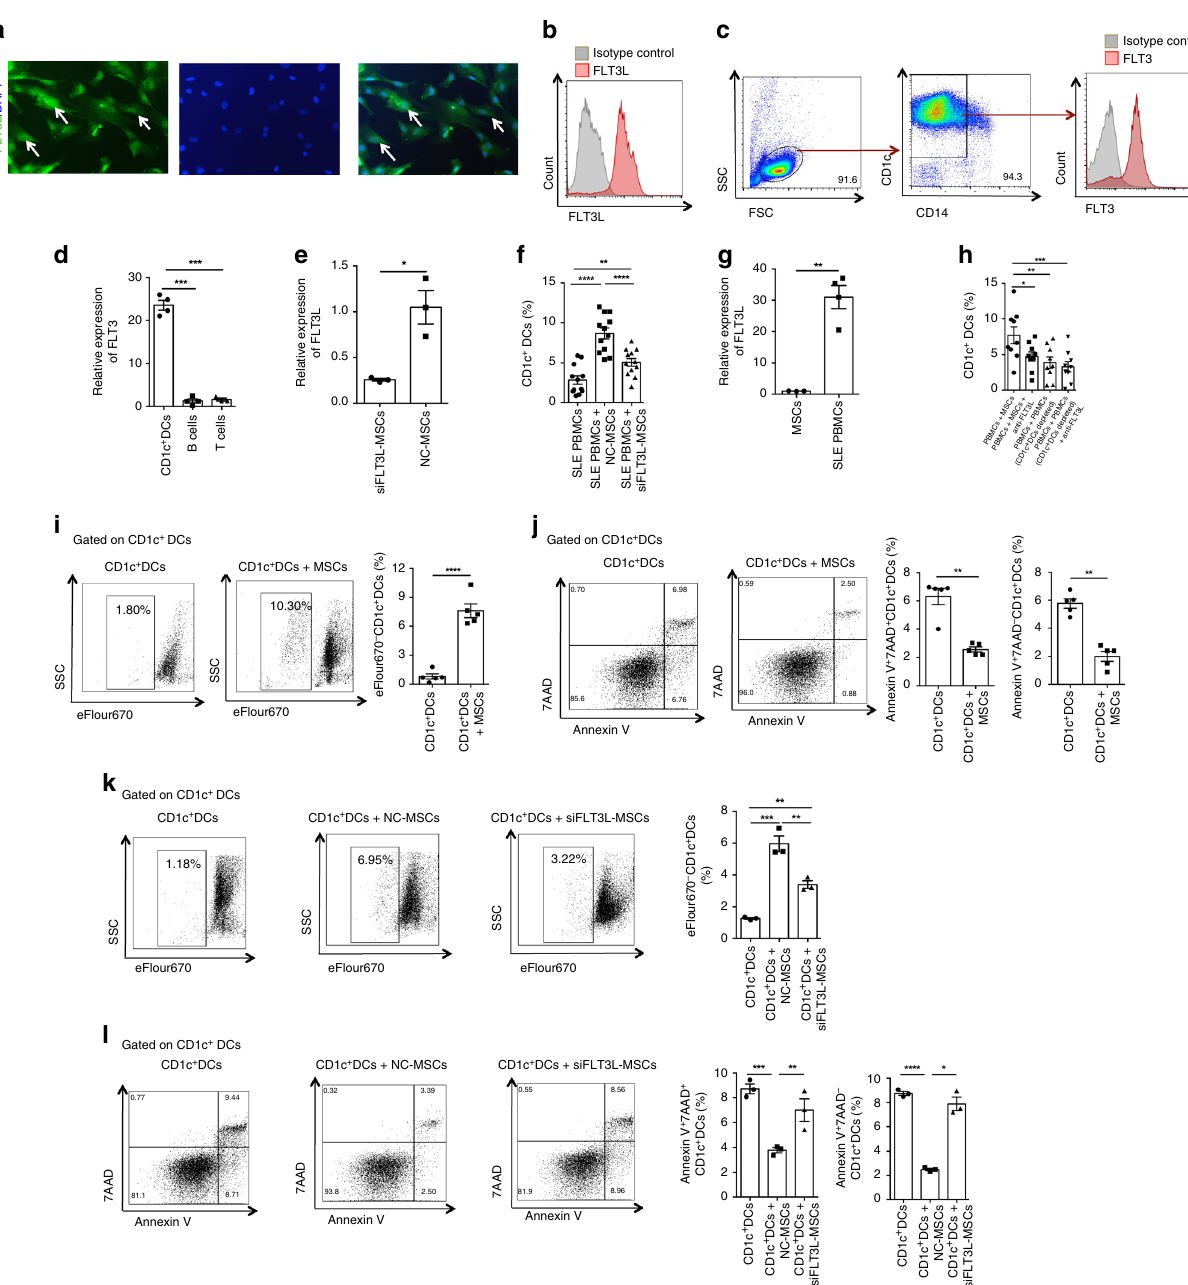
Fig. 4 UC-MSCs up-regulate CD1c + DCs via FLT3L. a The expression of FLT3L on UC-MSCs was assessed by immuno fl uorescence staining (Green: FLT3L; Blue: DAPI), white arrows represented FLT3L expression. b The expression of FLT3L on UC-MSCs was assessed by fl ow cytometry. c CD1c + DCs are isolated and identi fi ed by fl ow cytometry. Flow cytometry analysis showed the expression of FLT3 on CD1c + DCs. d The relative expression of FLT3 was compared among isolated CD1c + DCs ( n = 4), CD19 + B cells ( n = 4) and CD4 + T cells ( n = 3) by real-time PCR. e FLT3L siRNA was used to down-regulate FLT3L expression on UC-MSCs (siFLT3L-MSCs), negative control siRNA treated MSCs (NC-MSCs) were served as controls. The inhibition ef fi ciency of FLT3L siRNA was assessed in UC-MSCs by real-time PCR ( n = 3). f FLT3L siRNA was used to down-regulate FLT3L expression on UC-MSCs, then co- cultured with SLE PBMCs, and the frequency of Lin − HLA-DR + CD11c + CD1c + DCs was analyzed ( n = 12). g The expression of FLT3L on SLE PBMCs ( n = 4) was compared with that on UC-MSCs ( n = 3) by real-time PCR. h SLE PBMCs were co-cultured with UC-MSCs (PM group) or autologous PBMCs in which the CD1c + DCs were deleted (PP group) for 72 h. The frequency of CD1c + DCs was compared between the two groups. The neutralizing antibody against FLT3L was added to both PM and PP groups, the frequency of CD1c + DCs was evaluated in each group ( n = 9). i The proliferative rate of isolated CD1c + DCs cultured alone or co-cultured with UC-MSCs for 72 h ( n = 5). j The apoptotic rate of isolated CD1c + DCs cultured alone or co-cultured with UC- MSCs for 24 h ( n = 5). k , l FLT3L siRNA was used to down-regulate FLT3L expression on UC-MSCs, NC-MSCs were served as controls, then co-cultured with isolated CD1c + DCs, the proliferation ( k ) and apoptosis ( l ) of isolated CD1c + DCs were evaluated ( n = 3). The experiments were repeated ≥ 3 times (* p < 0.05, ** p < 0.01, *** p < 0.001, **** p < 0.0001 by t -test or one-way ANOVA), SEM. Source data were provided as a Source Data fi